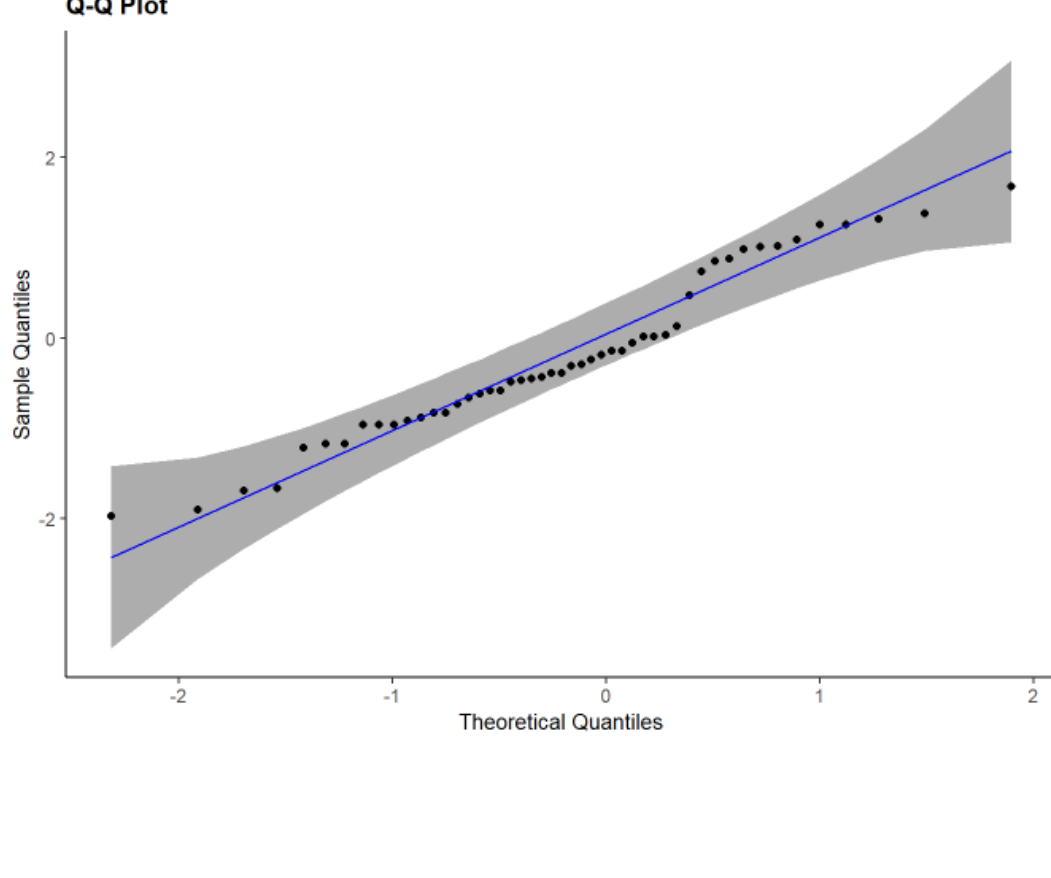
Figure 3. Residual Q-Q plots for the negative binomial models with 95% confidence bounds